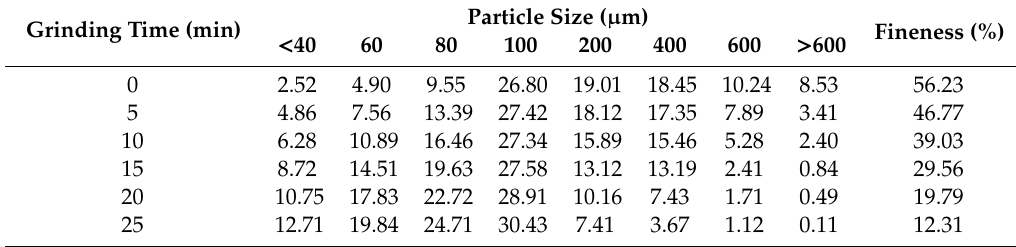
Table 10. Fineness of PG particles at di ff erent grinding